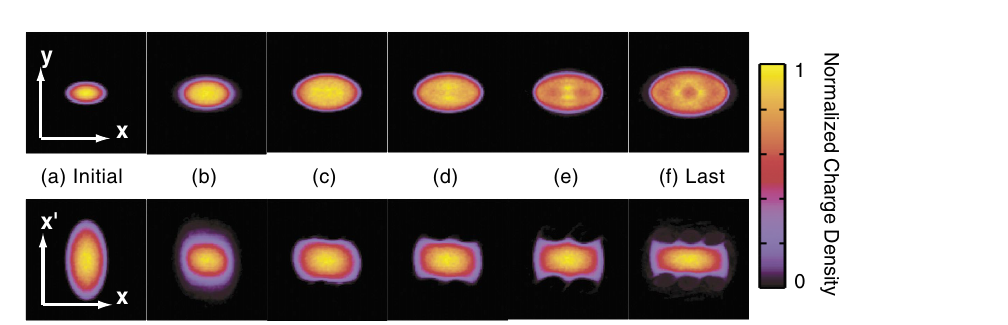
FIG. 3. (Color) Normalized charge density maps for real (top panels) and phase (bottom panels) spaces during transport with increasing beam current for initially WB distributed beam, (a) at initial condition, (b) at 50 lattice periods, (c) at 87 lattice periods, (d) at 96 lattice periods, (e) at 108 lattice periods, and (f) at 150 (last) lattice periods, respectively. The width and height correspond to 10 cm (cid:9) 10 cm in real space maps, and 10 cm (cid:9) 10 mrad in phase space maps. The charge density in the contour map is normalized by the maximum value at each lattice period, and the value is expressed by the bar of the color level placed at the right